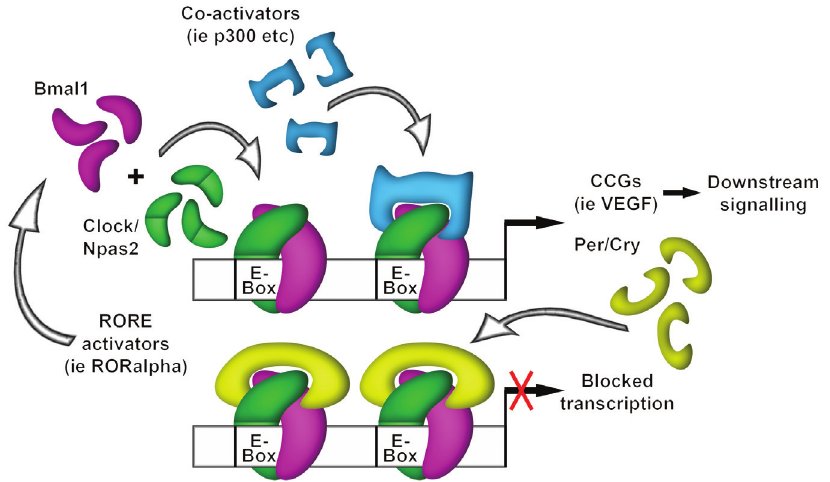
Figure 1 Scheme indicating the key players in the core circadian transcription-translation negative feedback loop. Following induction by RORE-binding factors such as ROR-alpha, Bmal1 (shown in purple) will accumulate, enter into the nucleus and bind the co-factors Clock or Npas2 (shown in green). The heterodimeric complexes bind to E-boxes in the promoters of target genes, and recruit co-factors such as p300 (shown in turquoise) to induce transcription of clock controlled genes (CCGs) such as VEGF, which elicit further downstream signalling important for angiogenesis, as well as members of the Period (Per) and Cryptochrome (Cry) families (shown in yellow). The latter will negatively feedback onto the Bmal1/Clock/Npas2 complex by repressing their transcriptional activation, thus creat- ing diurnal oscillations in CCG mRNA